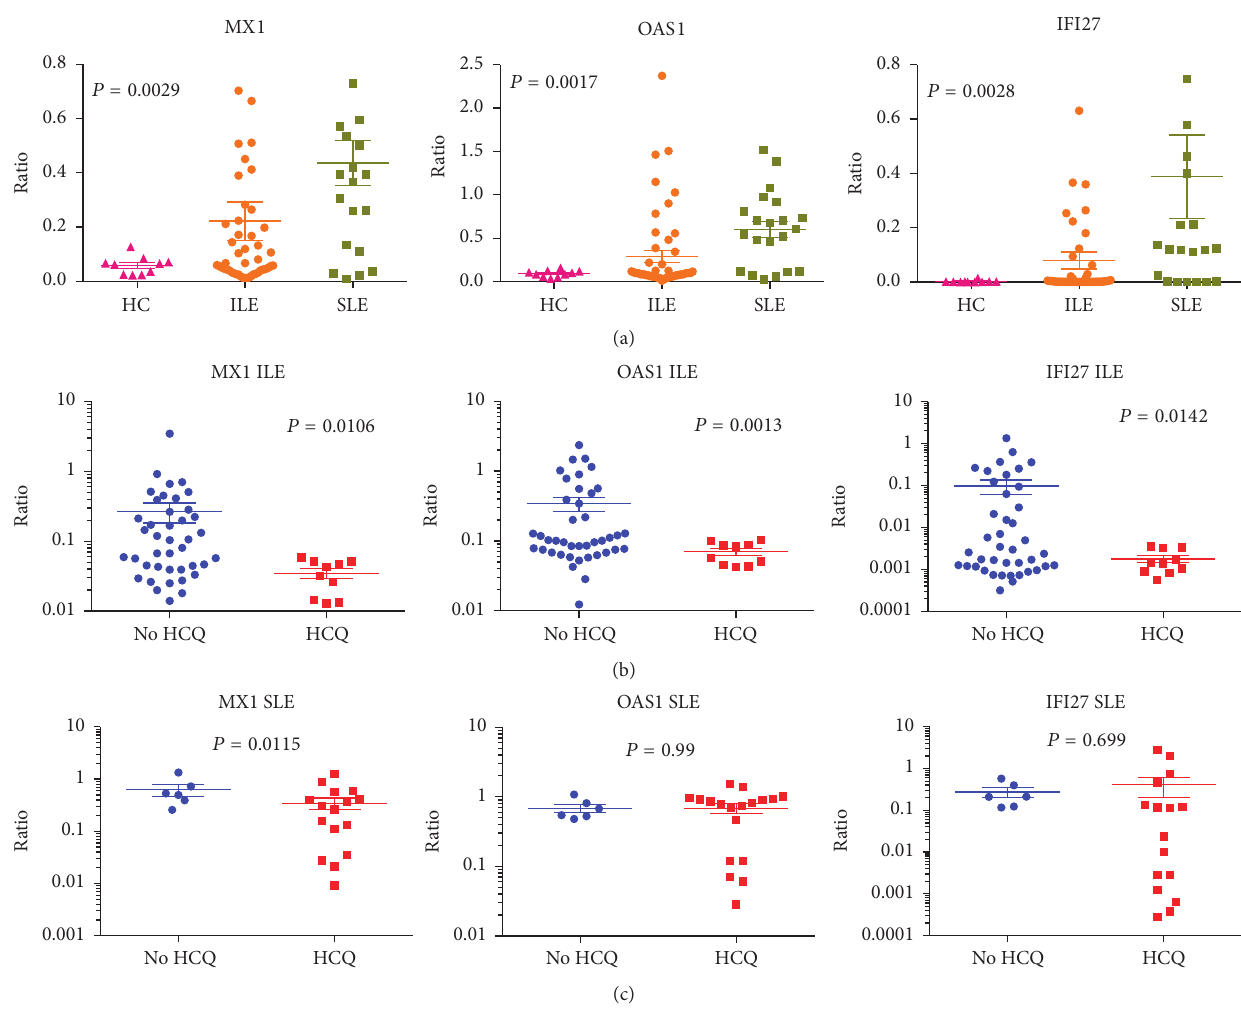
Figure 2: Expression levels of three specificities in the Type I IFN signature, MX1, OAS1, and IFI27, measured by RT-PCR, are shown in patients with ILE and SLE: (a) HC, ILE, and SLE groups; (b) ILE patients grouped by HCQ use; (c) SLE patients grouped by HCQ use. Values are expressed as a ratio relative to GAPDH, as described in the methods section. Individual data points are shown, with mean and SEM values also indicated. For 3-group comparisons in (a), 1-way ANOVA was used to calculate significance. HCQ and non-HCQ groups were compared in (b) and (c) using Student’s 𝑡